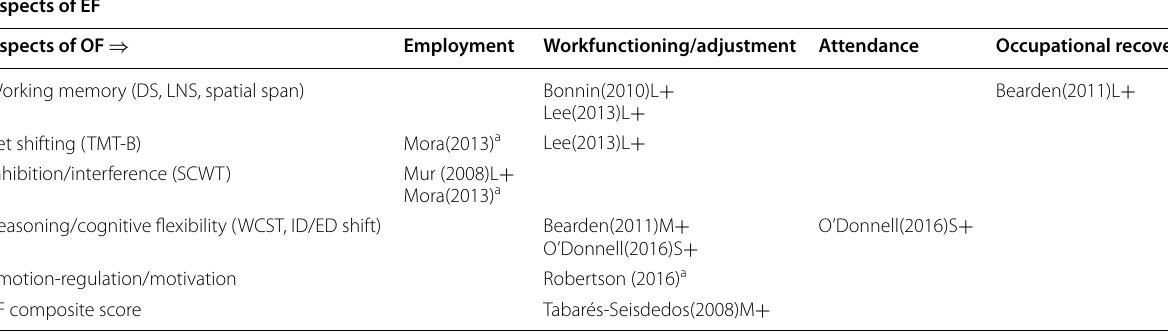
S small ES, M medium ES, L large